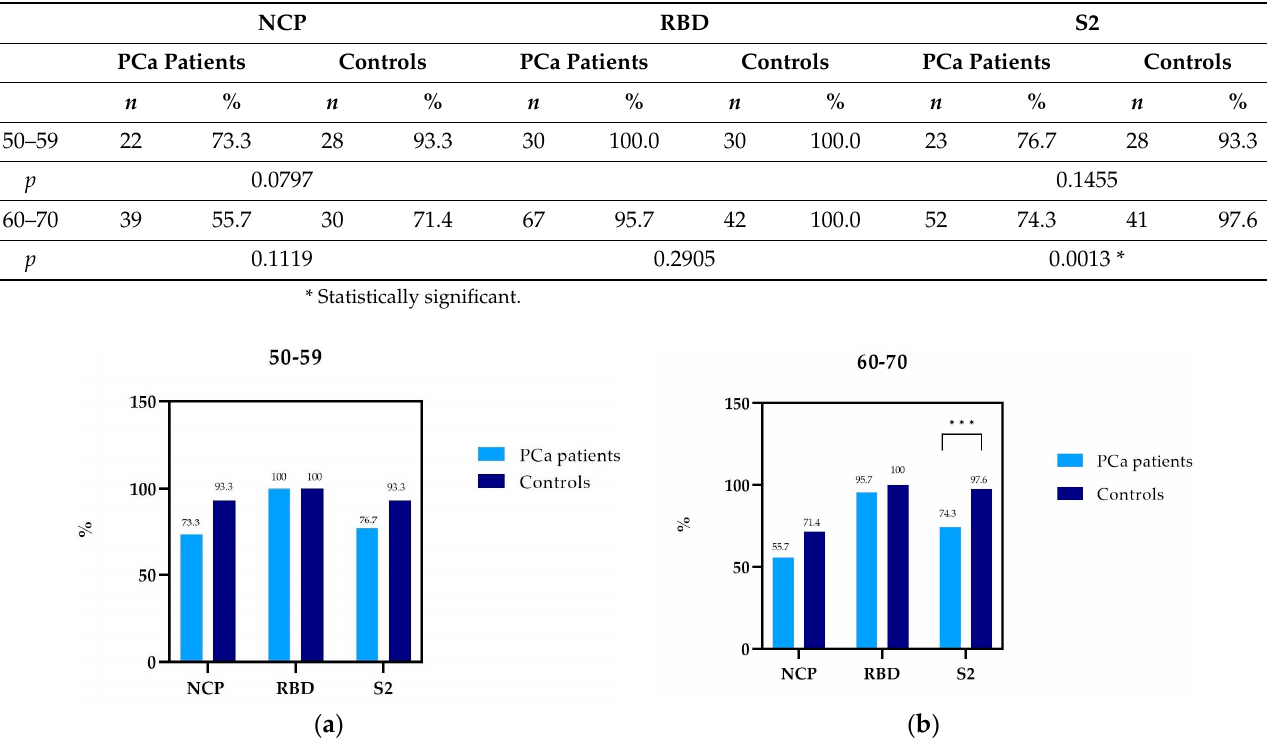
Figure 1. Prevalence of NCP, RBD, and S2 IgG antibodies in PCa patients and controls by age: ( a ) 50–59, ( b ) 60–70; *** statistically significant (10 − 3